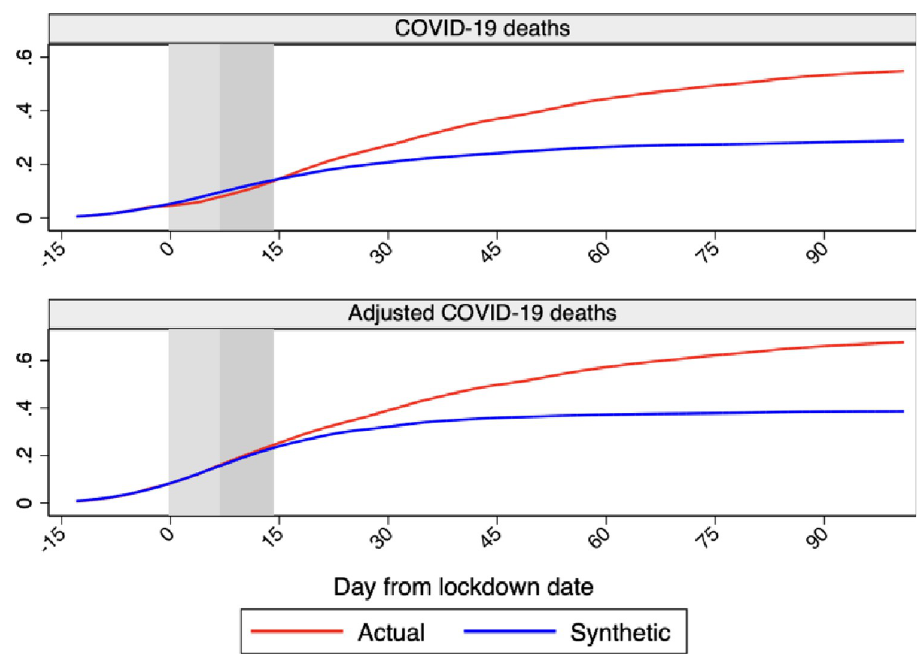
Fig 4. Profiles of cumulative COVID-19 deaths and COVID-19 adjusted deaths for Sweden and synthetic Sweden. Notes : The profiles of cumulative COVID-19 deaths and COVID-19 adjusted deaths for Sweden and synthetic Sweden are shown in the figure. Horizontal axis measures days since the lockdown start that is normalized at day 0. The red line shows the profile for Sweden and the blue line shows the profile for synthetic Sweden. The vertical bands indicate the first 14 days after the lockdown start, with the lightest color as the first 7 and the darker as additional 7 days. Data source: Our World in Data and Financial